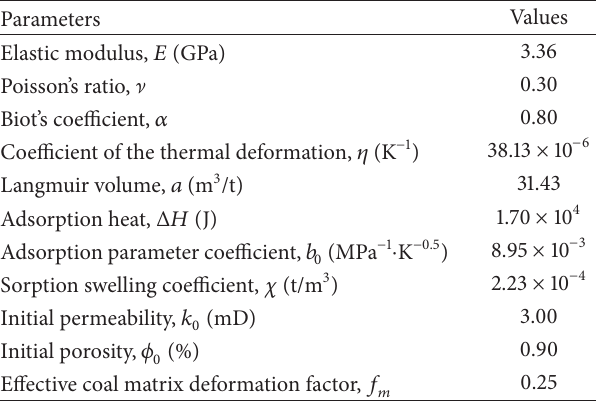
Table 2: The parameters for predicting permeability in the SQB.